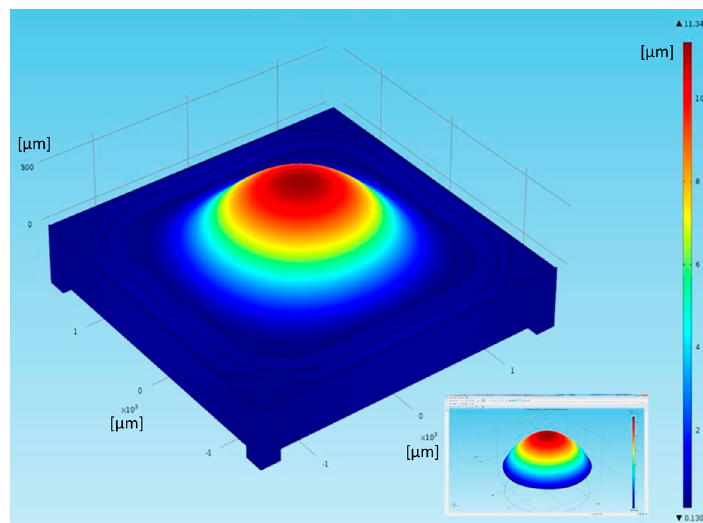
Figure 8. Results of a topographic measurement performed with a Polytec Micro-System Analyzer MSA 500 on a Tlens ® actuated with 20 V. On the z-axis, in false colors is height reached by the deformed surface of the lens. The maximum height variation in the center of the pupil is Δ z ~ 8.8 µm.